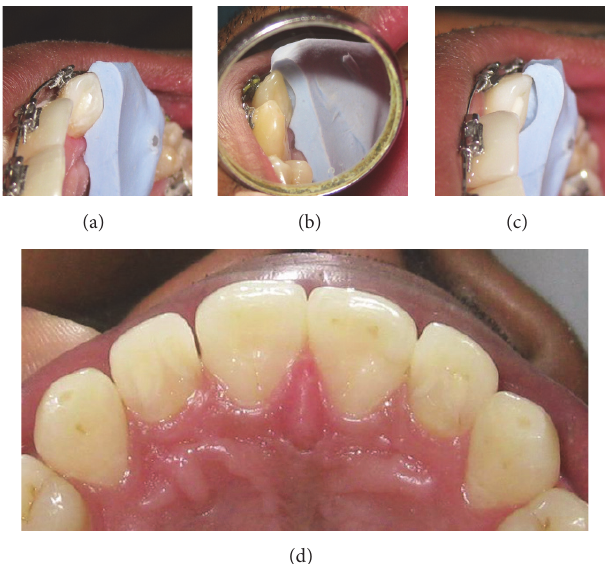
Figure 3: (a–c) Putty index used for tracking the amount of reduction; (d) following completion of treatment.